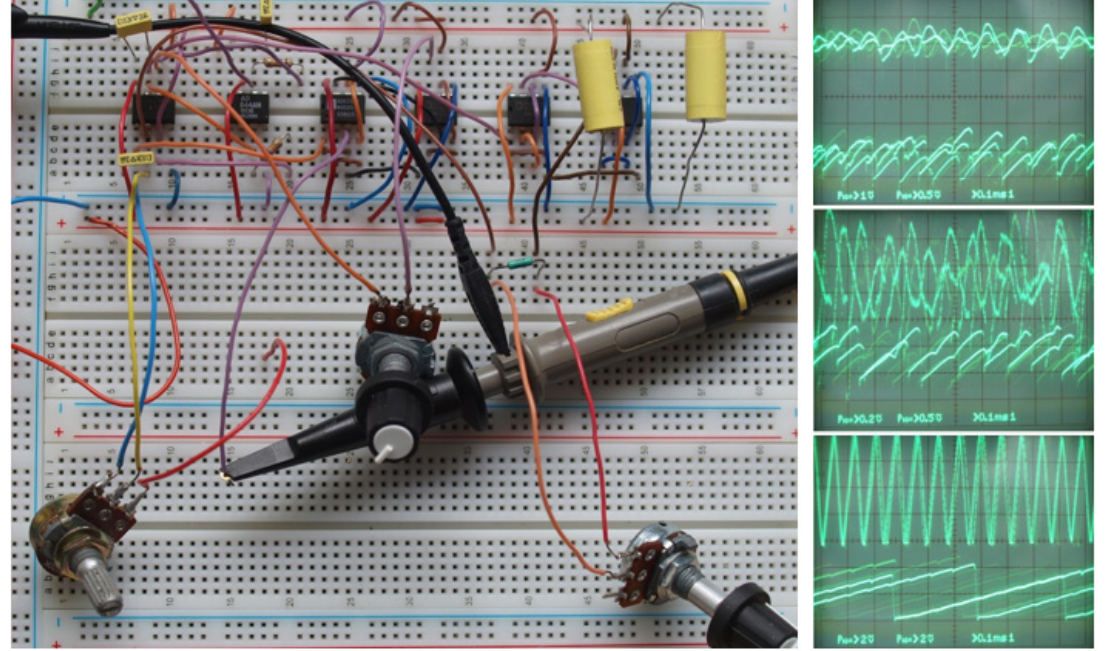
Figure 7. Detail photo of the chaotic oscillator realized using universal breadboard; generated chaotic waveforms in time domain visualized using an oscilloscope.